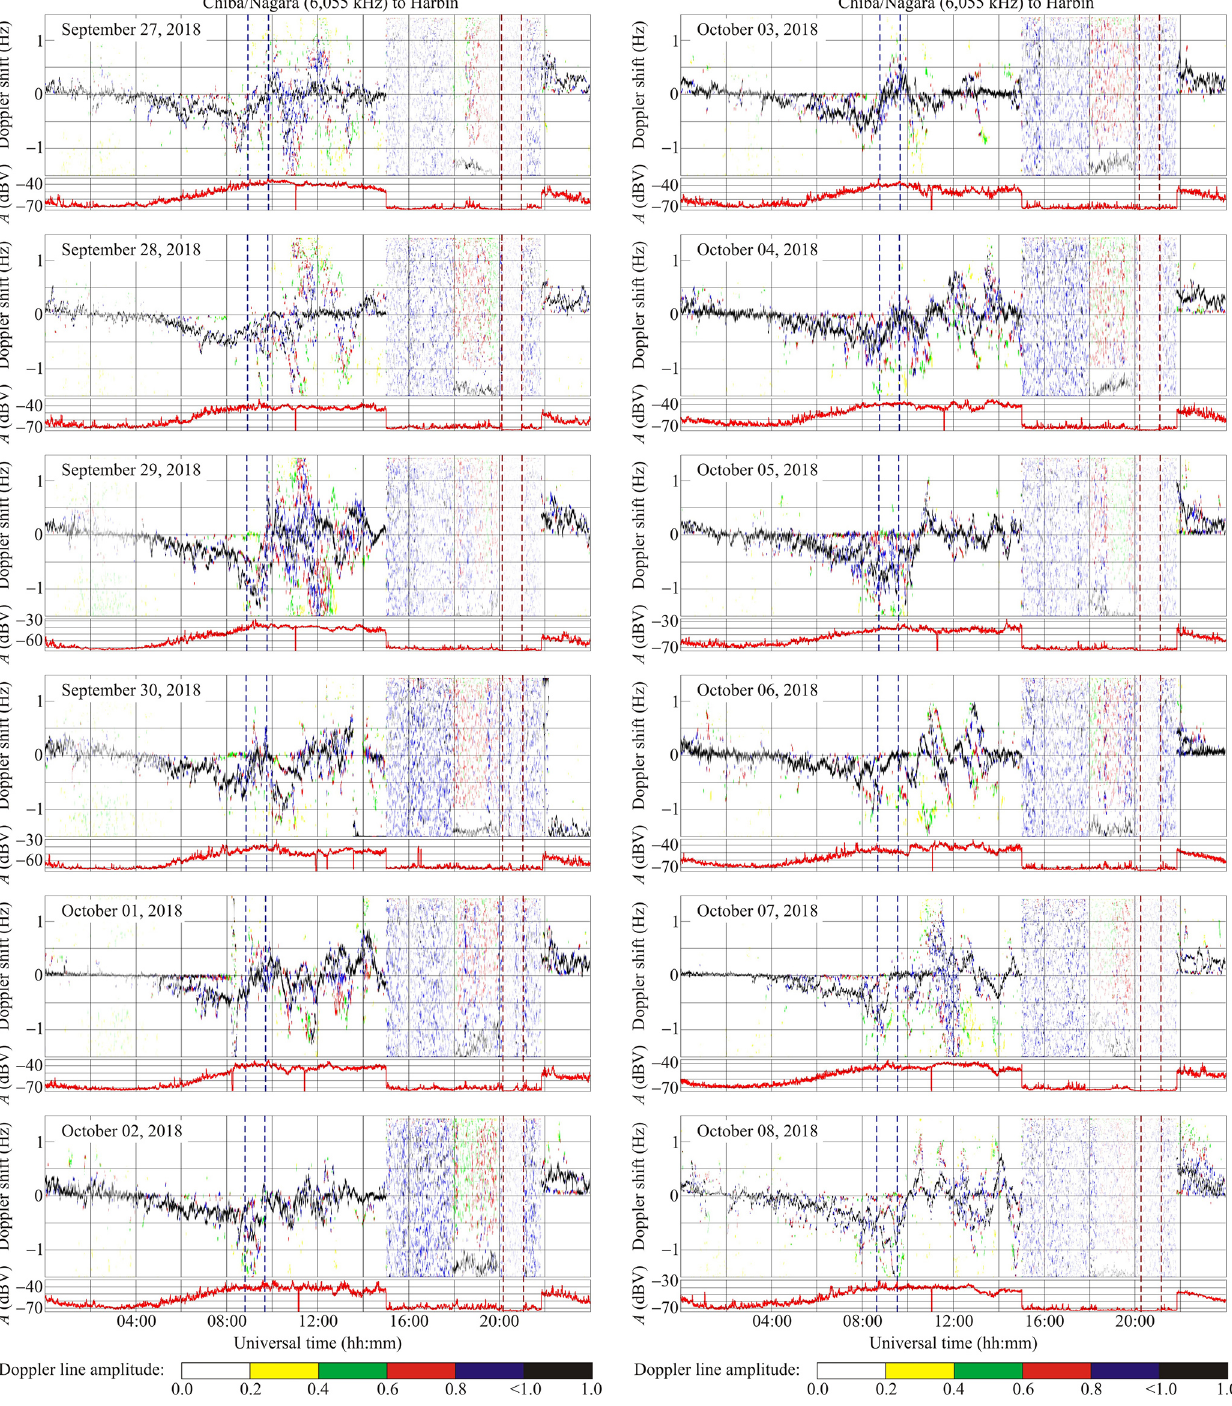
Figure 7. Same as in Fig. 6 but for the Chiba/Nagara to Harbin radio-wave propagation path at 6055kHz for the 27 September–2 October and 3–8 October 2018